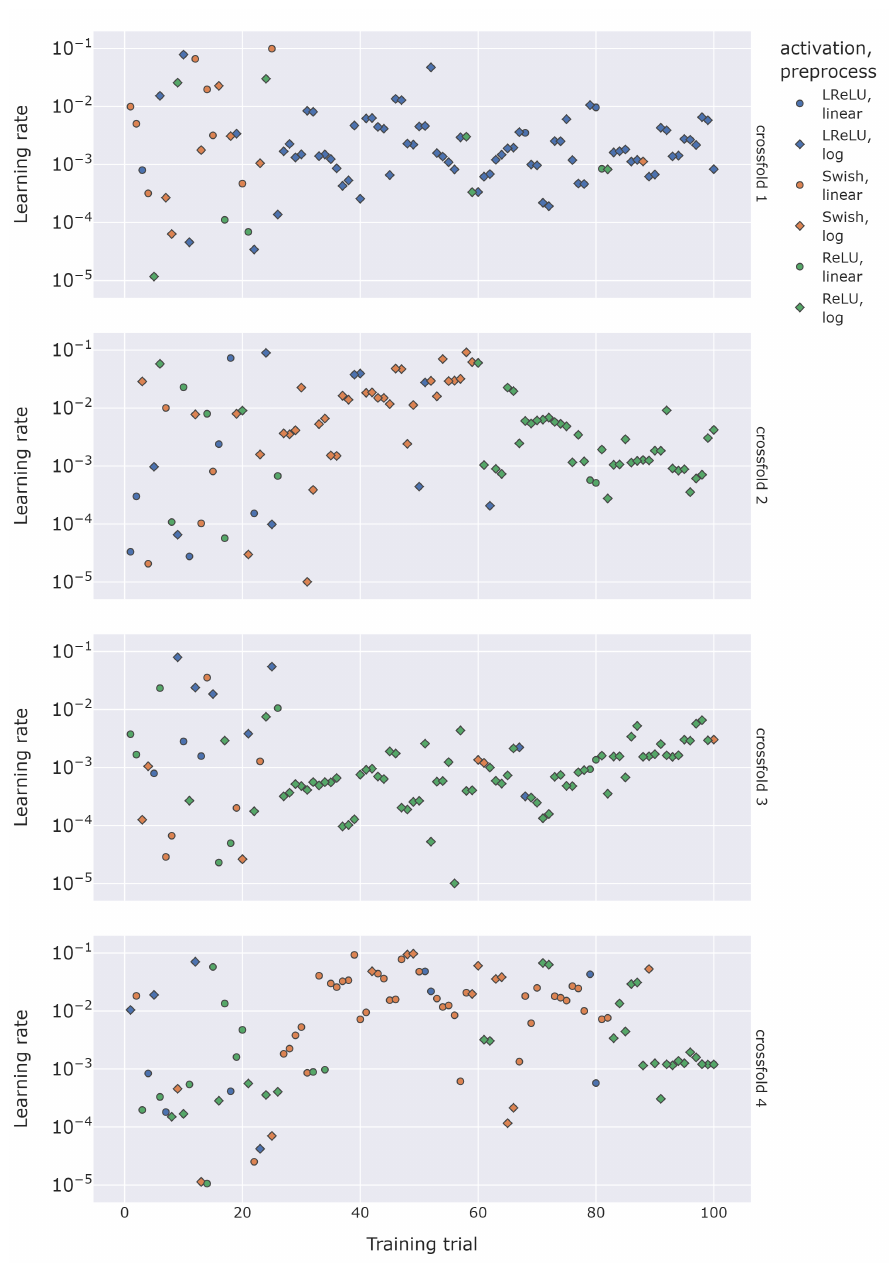
Figure 4. Changes in learning rate, activation function, and preprocessing method during trials for each